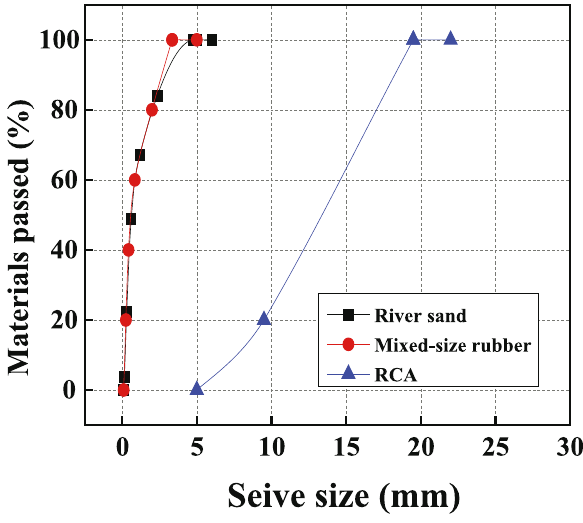
Figure 1: Sieve analysis results of